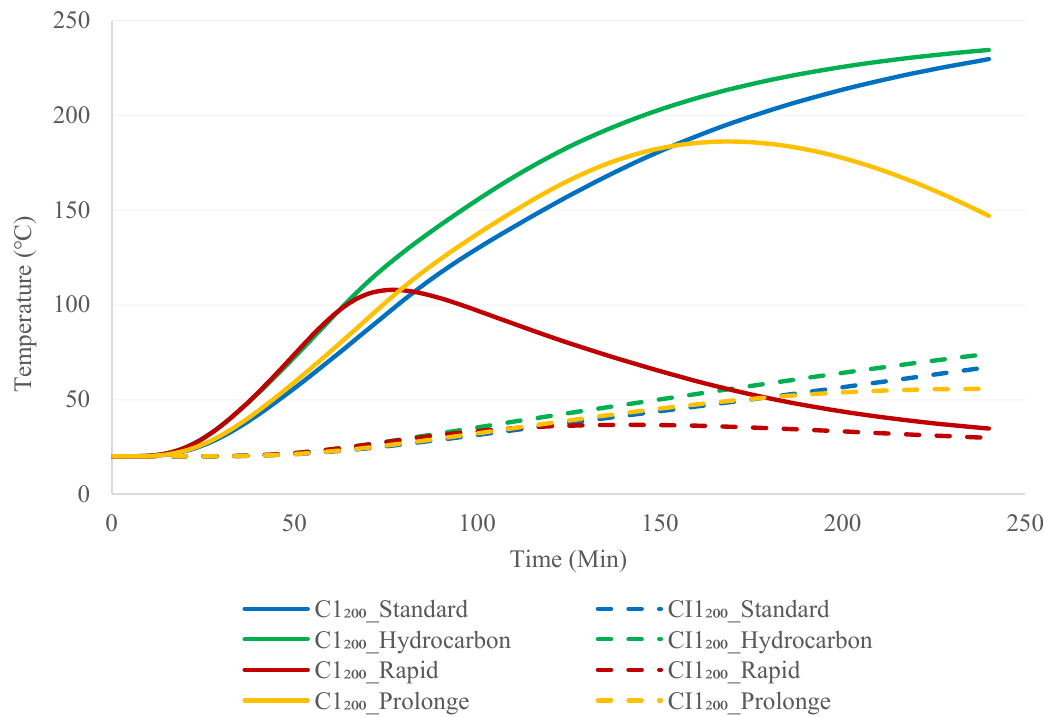
Figure 14. Unexposed surface temperature changes of 200mm wall configurations C1 and CI1 under different fire conditions.